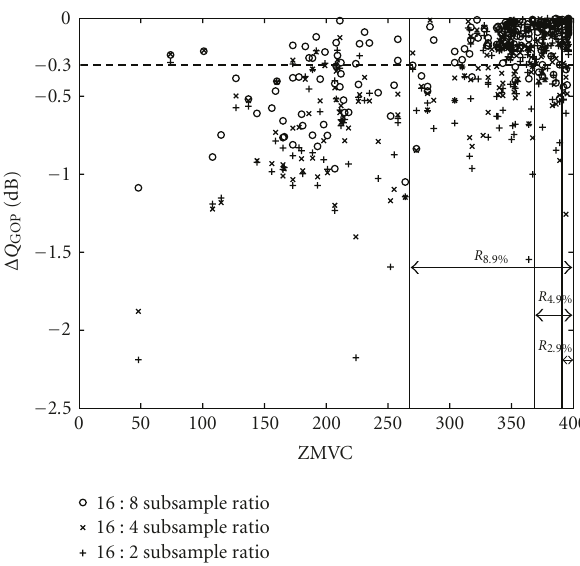
Figure 3: The diagram of Δ Q with 16:8, 16 :4, 16 :2 subsample ratios for table sequence.